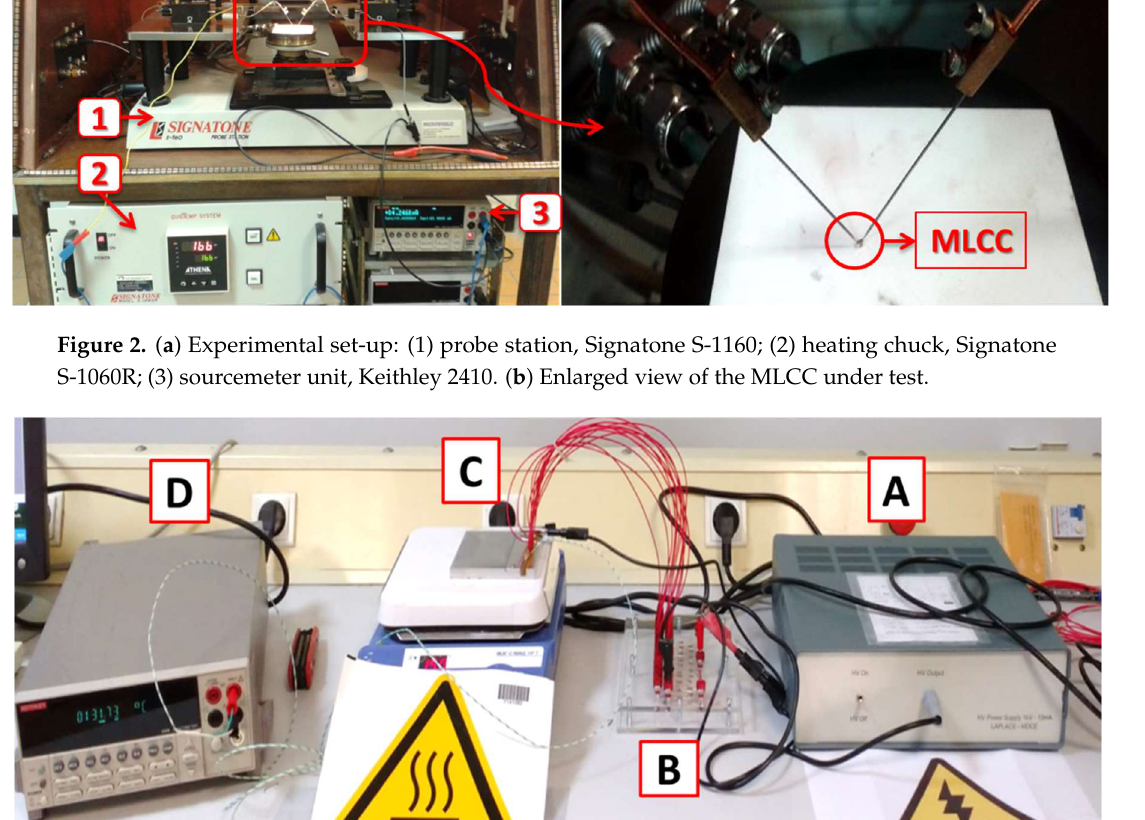
stress was applied.